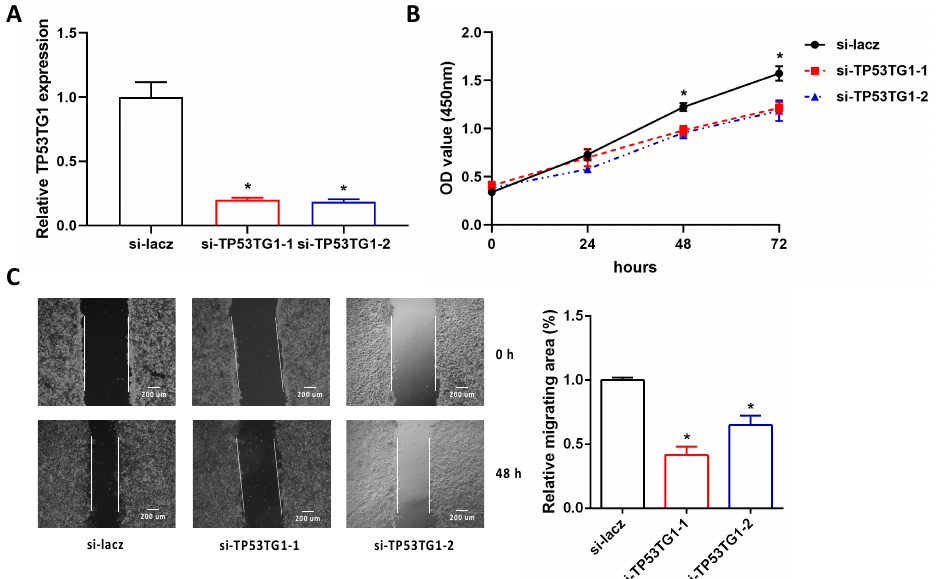
Figure 2. Knockdown of TP53TG1 suppresses cell proliferation and migration in HepG2. ( A – C ) The RNA expression level of TP53TG1 (normalized to 18S), n = 3 ( A ), proliferation rate, error bars represent SD, n = 6 ( B ) and migration rate, n = 3 ( C ) in HepG2 cells transfected with lacz siRNA or TP53TG1 siRNAs. * p < 0.05 (si-RNA vs.